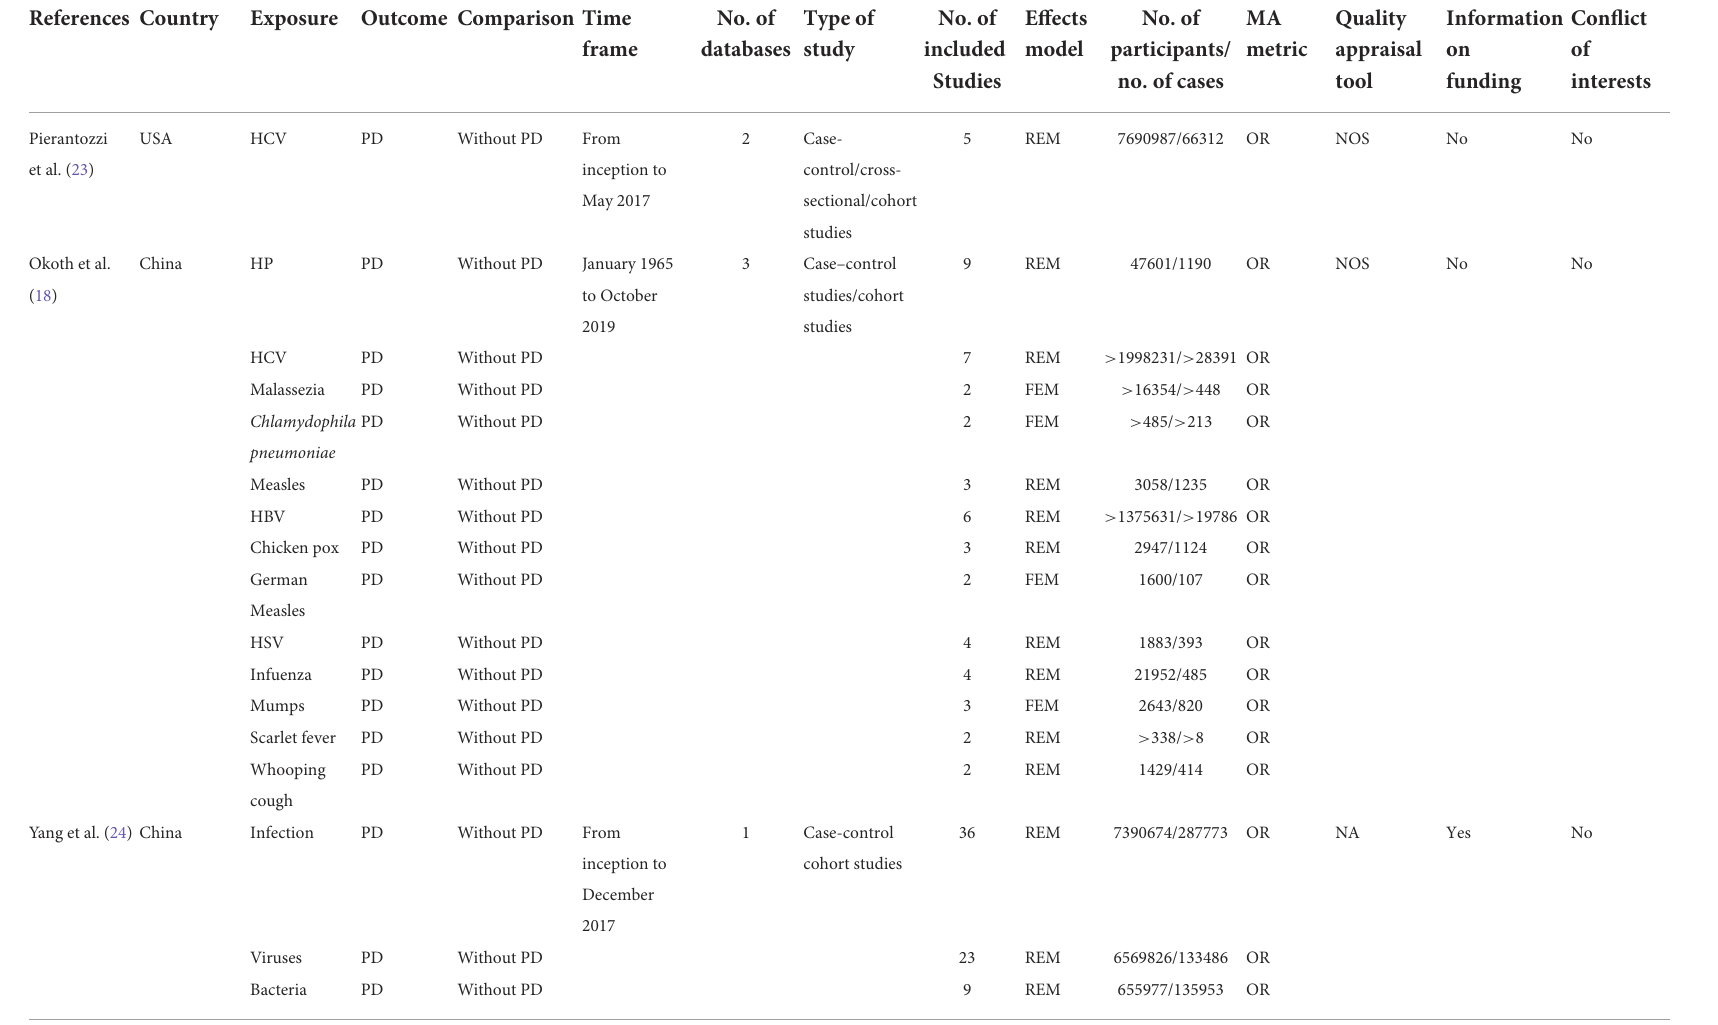
TABLE 1 Overall characteristics of meta-analyses included in the umbrella